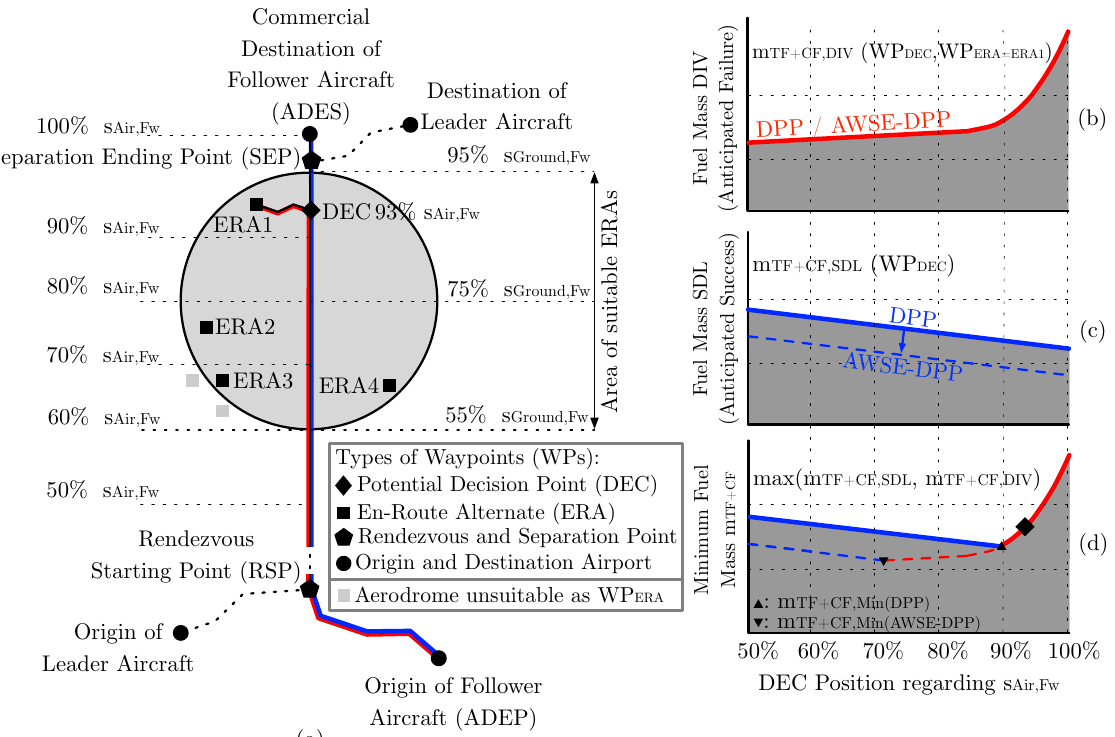
Figure 1. According to DPP [2], the follower’s amount m TF + CF is calculated for two cases: firstly up to ERA, according to Equation (1) (red line), secondly up to ADES, according to Equation (2) (blue line). The respective higher value is selected for fuel planning to ensure safety for all events. The adapted variant AWSE-DPP takes AWSE benefits into consideration for an anticipated success (SDL) and neglects them for an anticipated failure (DIV). ( a ) formation mission geometry including relevant parameters for AWSE-DPP; ( b – d ) Qualitative visualization of m TF + CF according to Equations (1)–(3) under consideration of